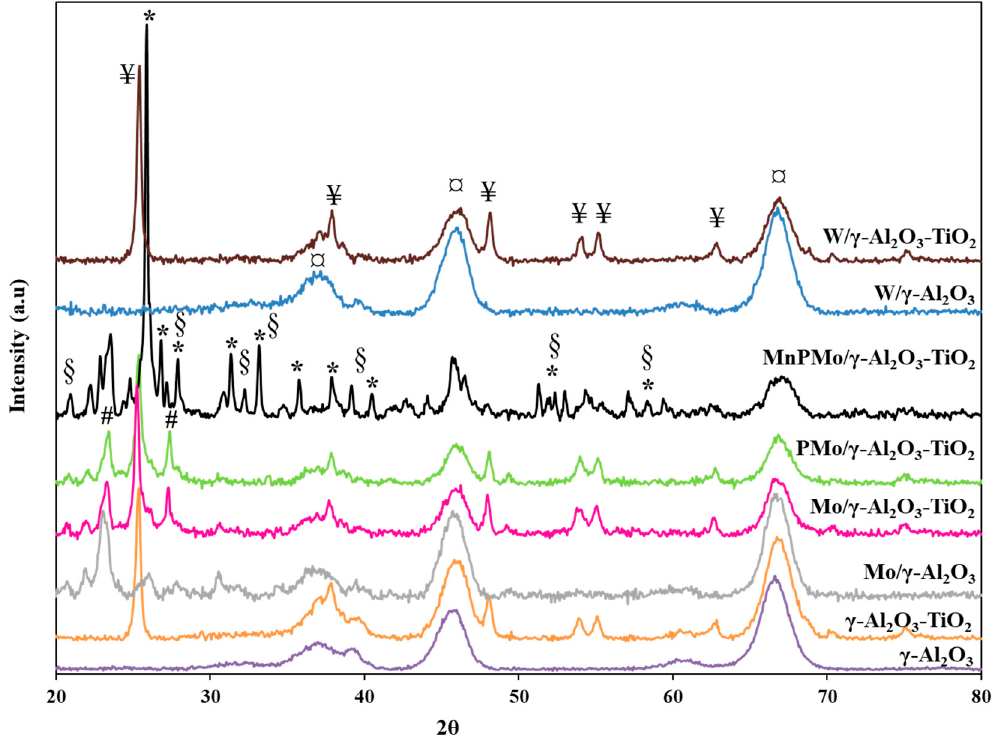
Figure 3. X-ray diffractograms of all catalysts. (§ — Mo 4 O 11 , ¥ — TiO 2 (anatase phase), * —α -MnMoO 4 , ¤ —planes of γ -Al 2 O 3 , # — MoO 3 ).